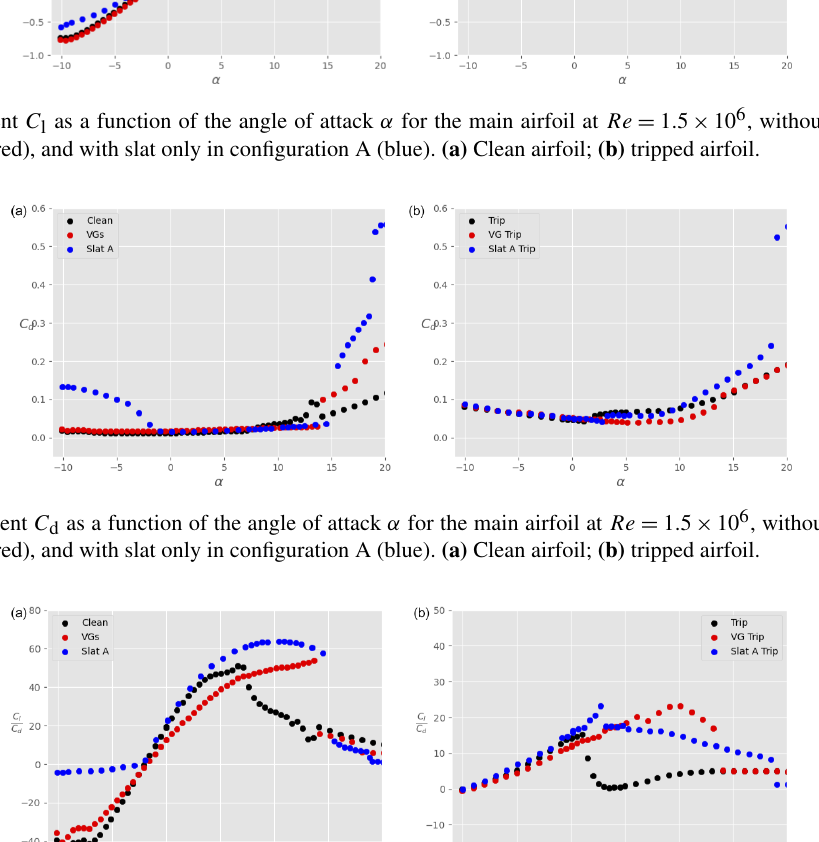
Wind Energ. Sci., 7, 573–584, 2022